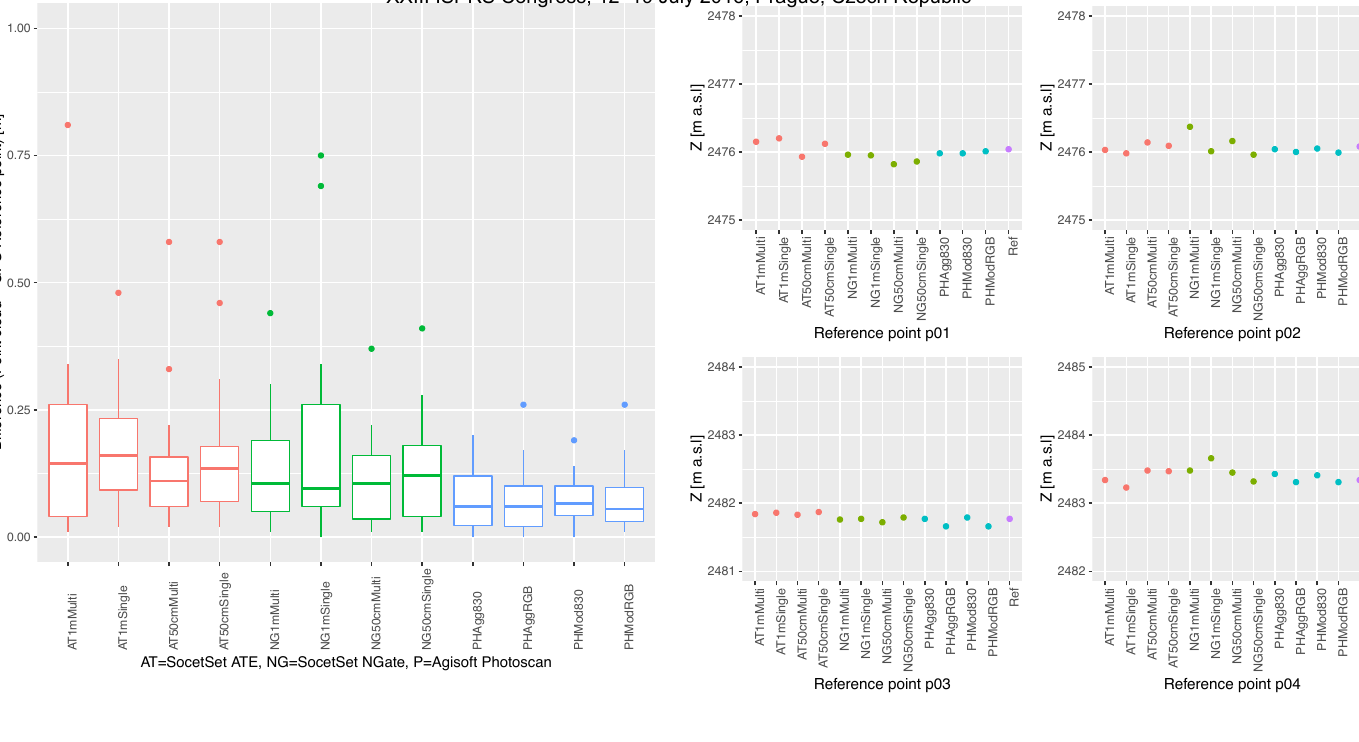
n=20, pcl=point cloud, ref=reference point